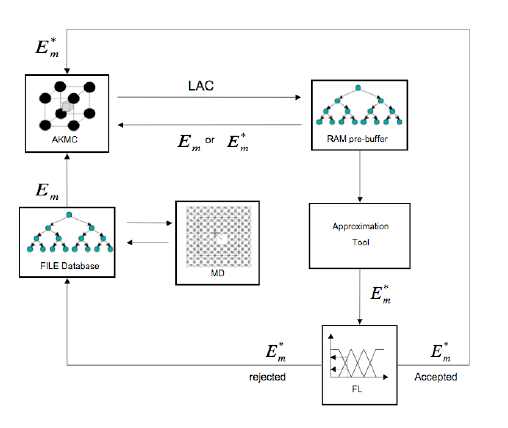
Fig. 3. The evolutionary VME prediction system.